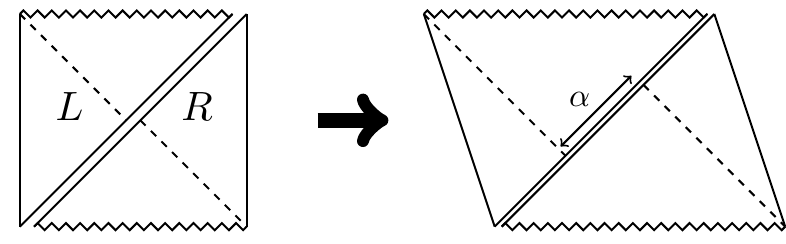
Figure 2 . Penrose diagram for the shock wave